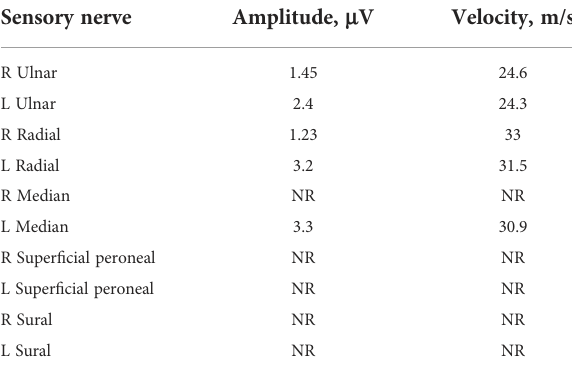
TABLE 1 Sensory nerve